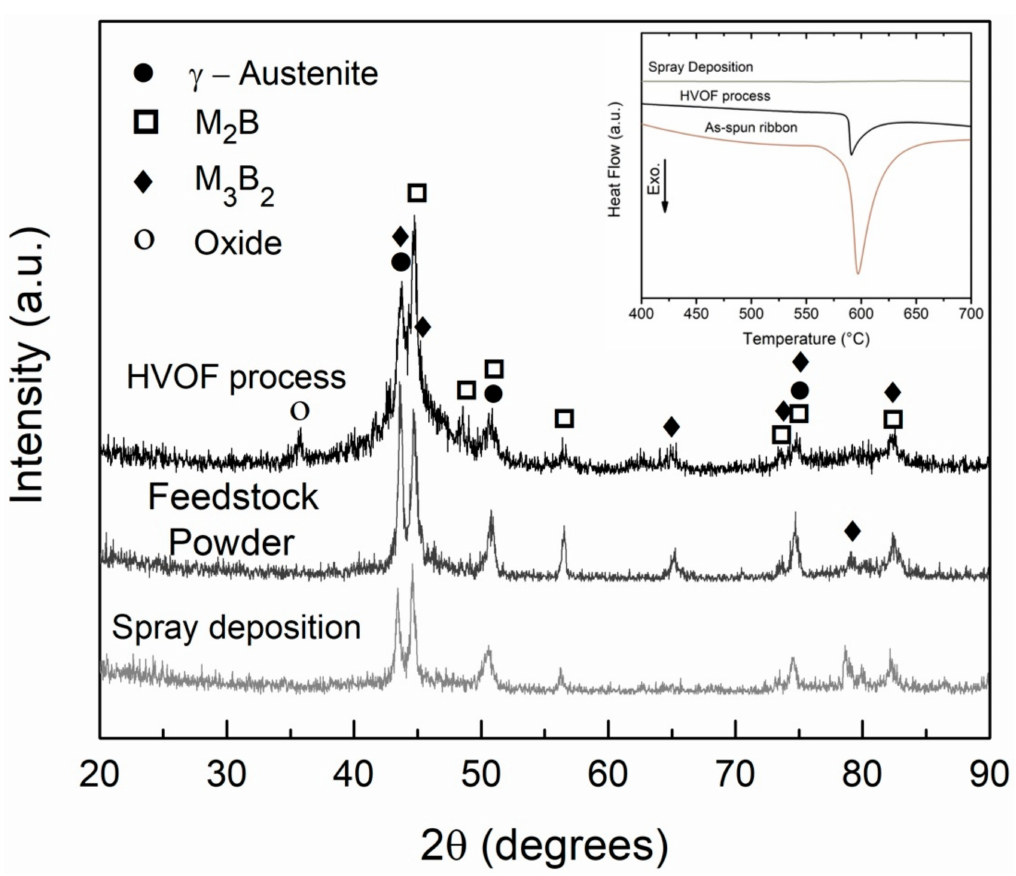
Figure 7. XRD curves of 63.5Fe25Cr7Ni4.5B spray deposited samples and feedstock powders and resulting HVOF coatings. Inset: DSC curves for 63.5Fe25Cr7Ni4.5B samples produced by melt-spinning, HVOF process, and spray